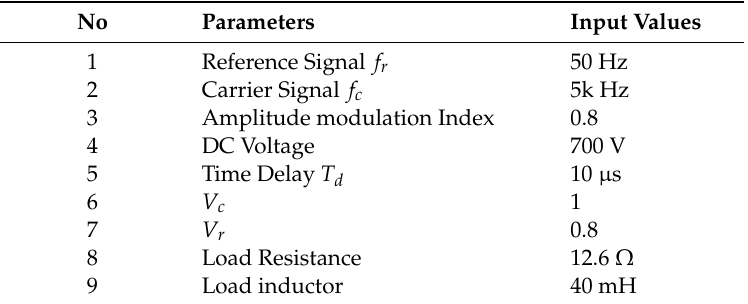
Table 2. Relevant parametric values of the Simulink Model.